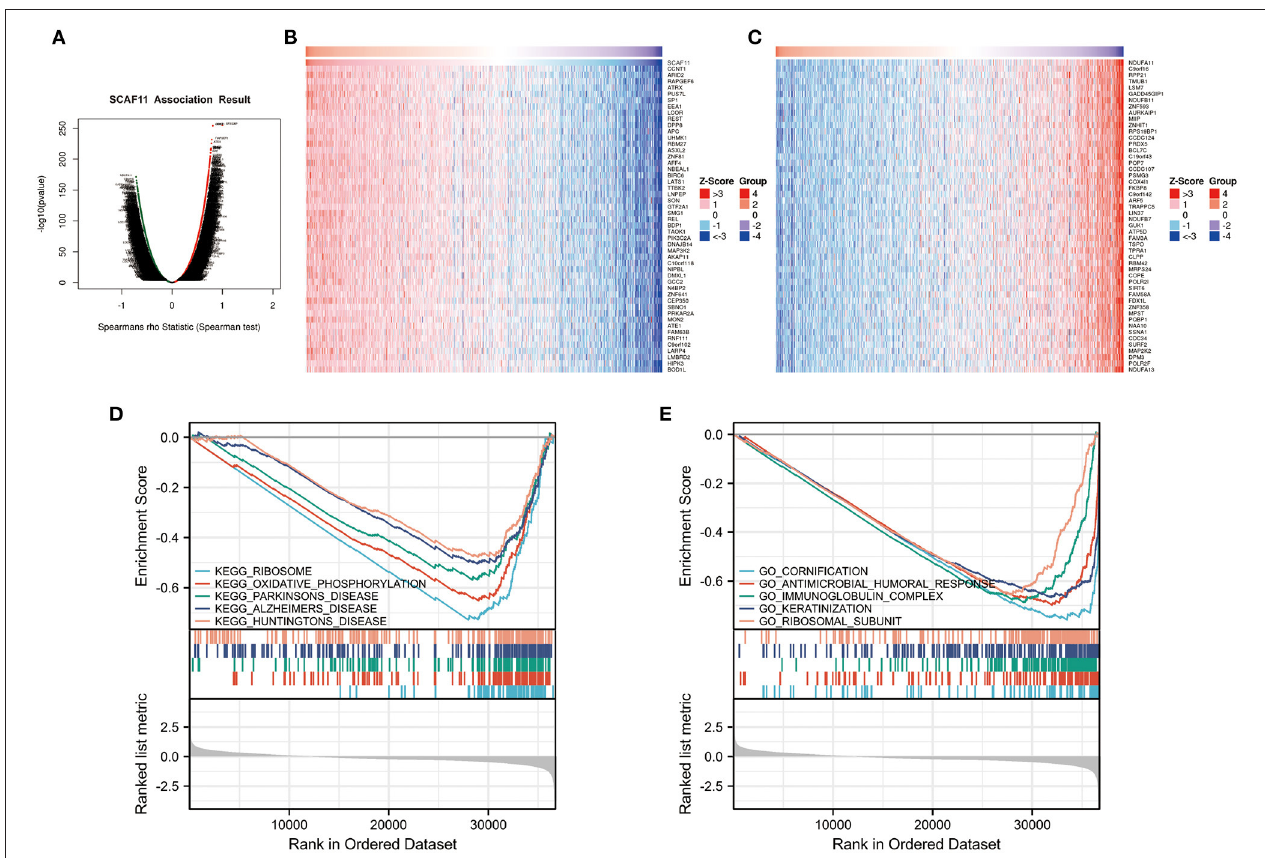
FIGURE 7 | The co-expression genes with SCAF11 from the LinkedOmics database and GSEA enrichment analysis from Xiantao tool. (A) Volcano plot showing genes significantly associated with SCAF11 by Spearman test. (B,C) Heatmaps of the top 50 genes positively and negatively correlated with SCAF11, respectively. (D,E) KEGG and GO pathway